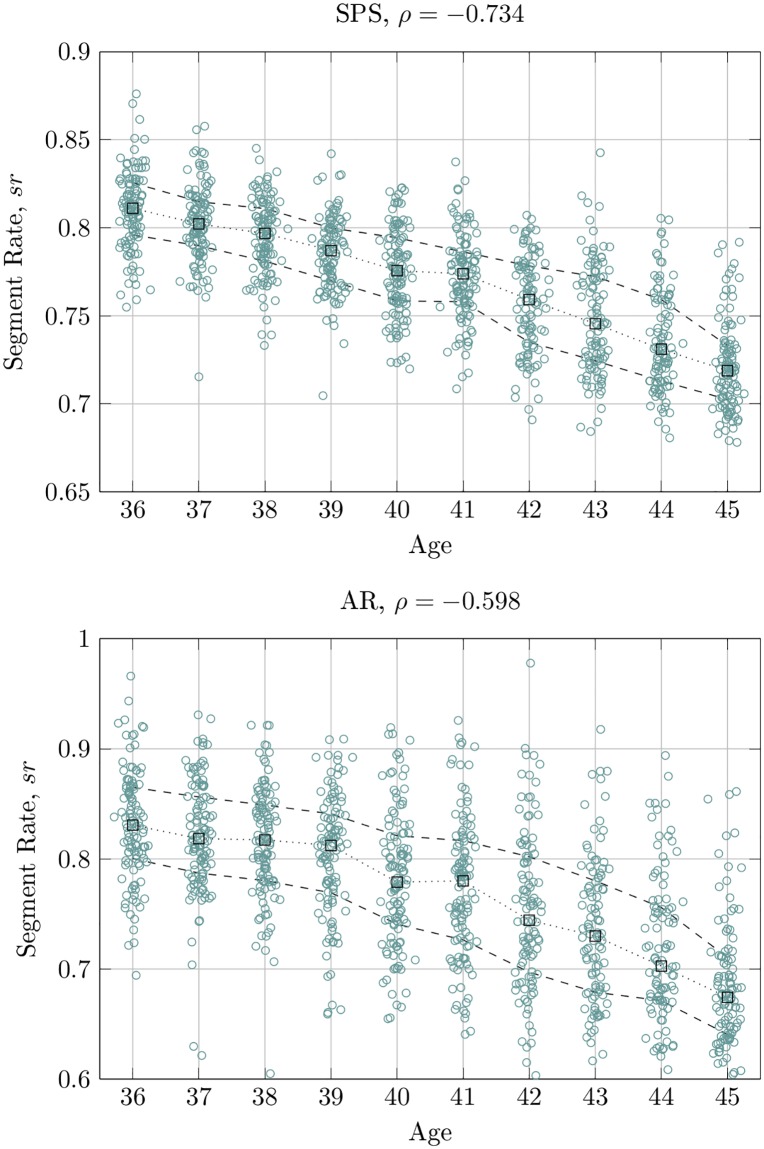
Correlation of the sr features extracted by the SPS and AR techniques.The circles represent sr values calculated for an EEG recording. The squares represent the median, and the dashed lines denote the 25th and 75th percentiles.